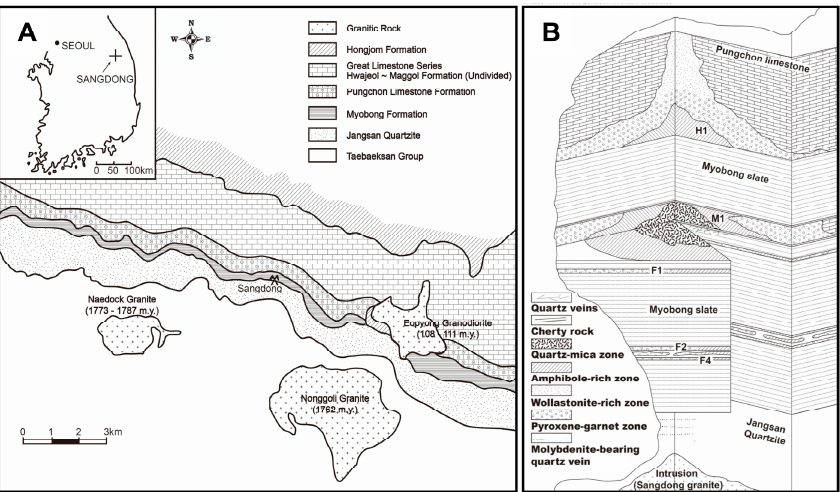
Figure 1. ( A ) Regional geologic map of the Sangdong W-deposit in the Taebaeksan mineralized district, including neighboring granitic bodies (modified from [16]). ( B ) Schematic cross-section of the Sangdong W-deposit including orebodies (modified from [28]; H: hanging wall orebody, M: main orebody, F: footwall